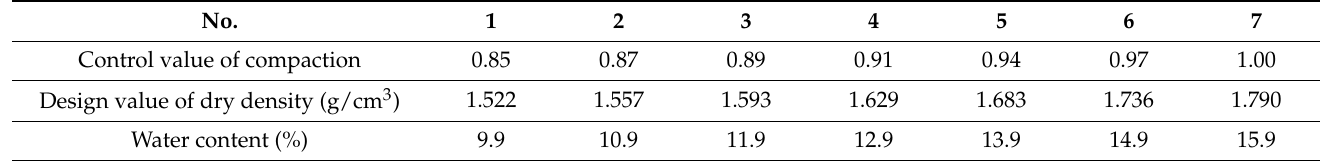
Table 2. Groups of soil samples for test of valid range of soil density.